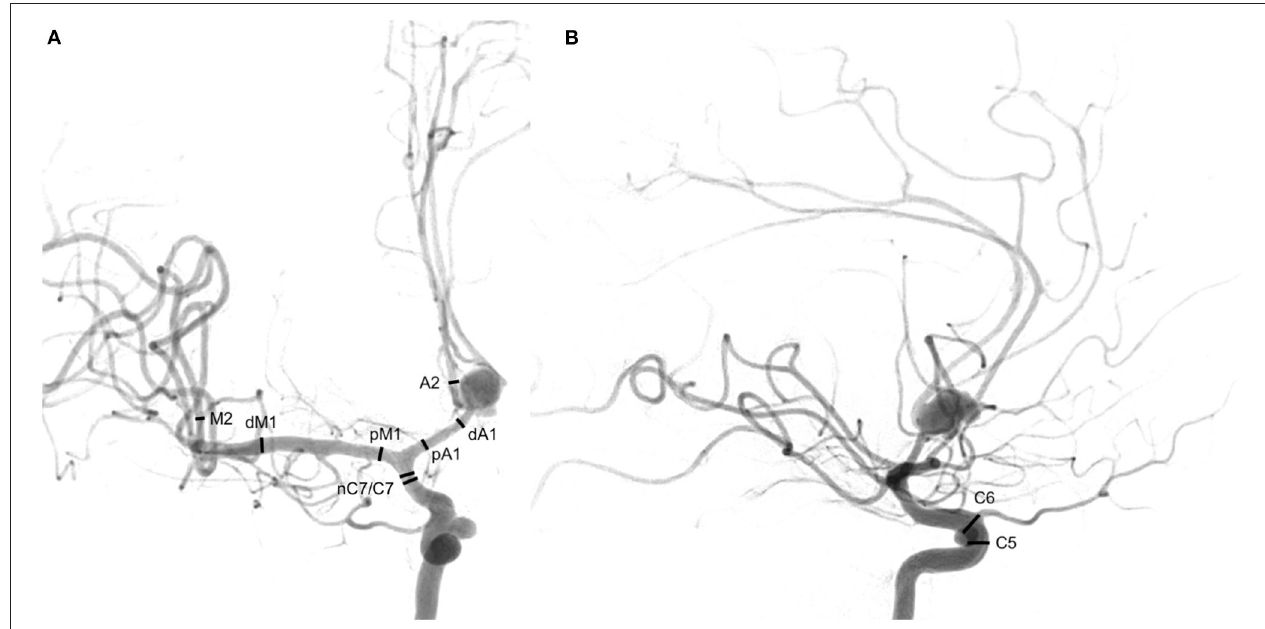
FIGURE 1 | Ten measured points. (A) Posterior-anterior projection of an internal carotid artery angiogram, C7 terminal segment of the internal carotid artery, nC7 narrowest point of C7, pM1 proximal horizontal segment of the middle cerebral artery, dM1 distal horizontal segment of the middle cerebral artery, M2 insular segment of the middle cerebral artery, pA1 proximal pre-communication segment of the anterior cerebral artery, dA1 distal pre-communication segment of the anterior cerebral artery, A2 post-communicating segment of the anterior cerebral artery. (B) Lateral projection of an internal carotid artery angiogram, C5 clinoid segment of the internal carotid artery, C6 ophthalmic segment of the internal carotid artery. In lateral projection: C5: 2mm proximal to the origin of the ophthalmic artery and C6: at the origin of the ophthalmic artery. In posterior-anterior projection: C7: 2mm proximal to the carotid T, nC7: the narrowest location in vasospastic arteries of C7 segments, pM1: 2mm distal to carotid T, dM1: 2mm proximal to middle cerebral artery bifurcation, M2: 4mm distal to the M1/M2 transition, pA1: 2mm distal to carotid T, dA1: 2mm proximal to change of course and A2: 2mm distal to change of course.